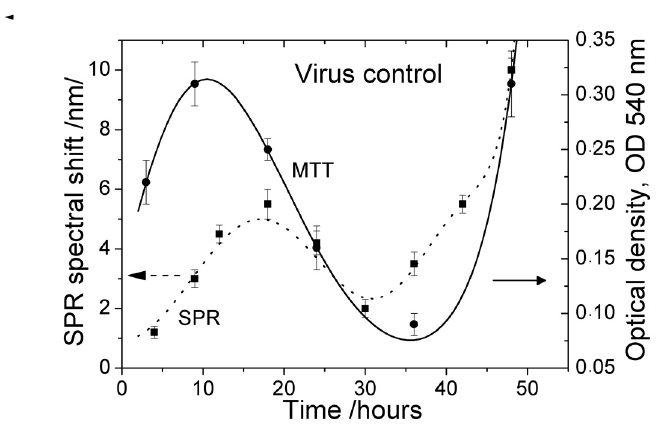
Figure 5. Growth kinetics of HCoV-229E-infected cells: dotted line—SPR results (virus control); solid line—MTT results.